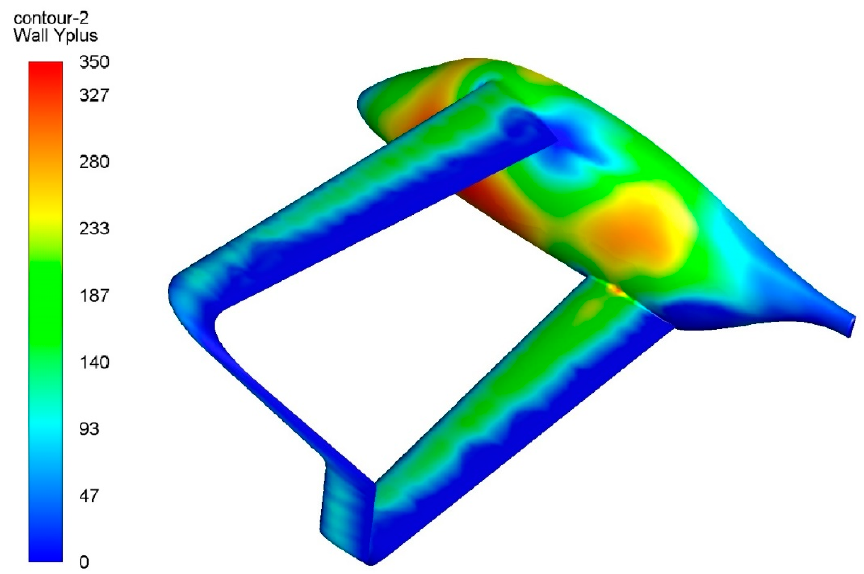
Figure 3. Fragments of the computational domain and local mesh.